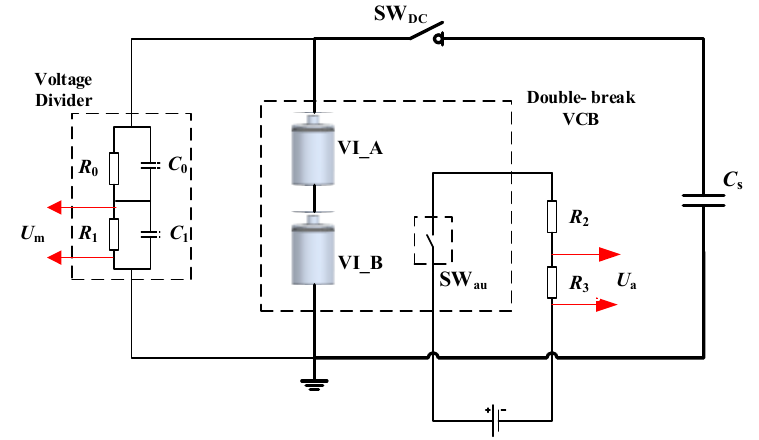
Figure 1. Schematic diagram of the experimental circuit.